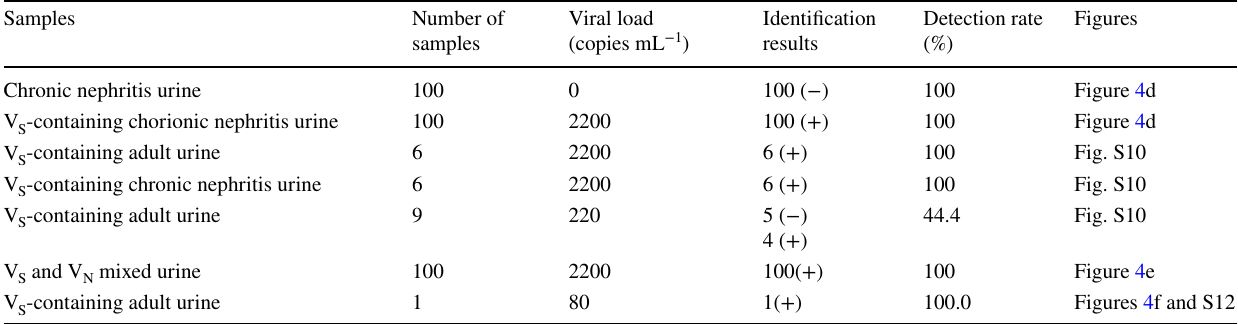
Table 1 DA results to identify V S ‑containing adult urines, V S ‑containing chronic nephritis’s urines, and Very‑low‑titer V S ‑containing adult